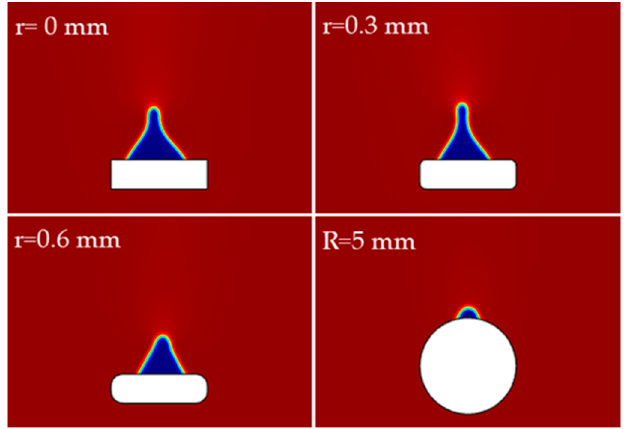
Figure 12. Gas residue when steel wires with different cross-sectional shapes are used.